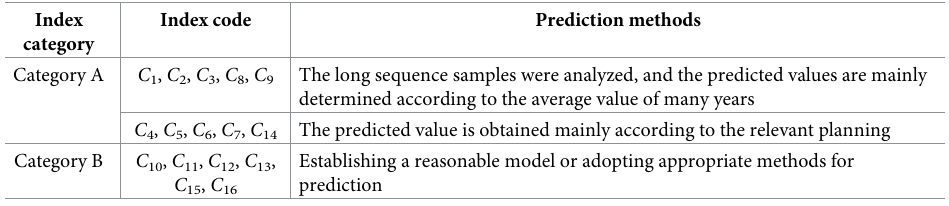
Table 2. Prediction methods of different evaluation